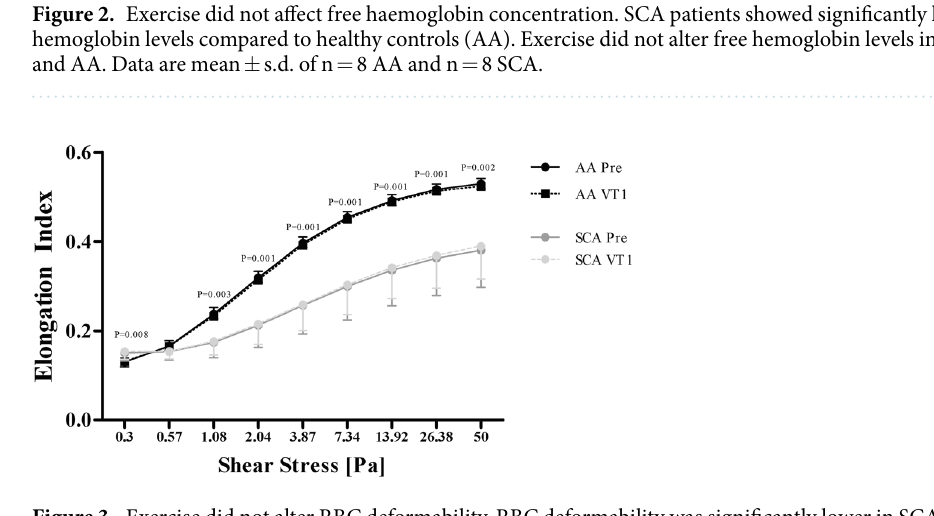
Figure 3. Exercise did not alter RBC deformability. RBC deformability was significantly lower in SCA patients at rest and VT1. Exercise did not affect RBC deformability in the tested groups. Data are mean ± s.d. of n = 8 AA and n = 8 SCA.